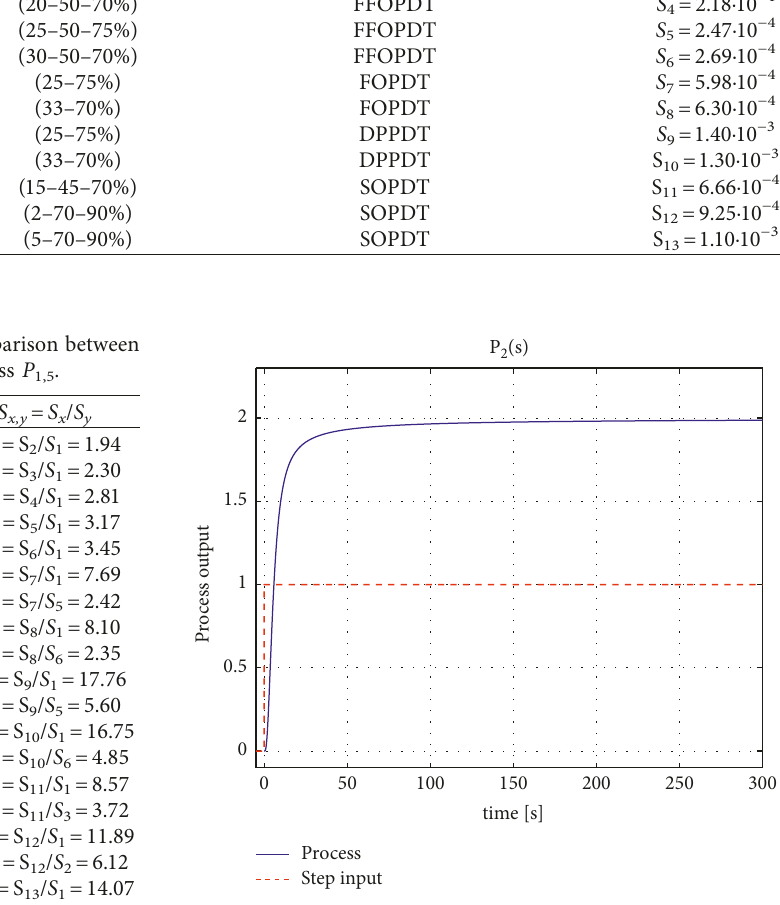
Table 18: Time-domain model performance indices for process P